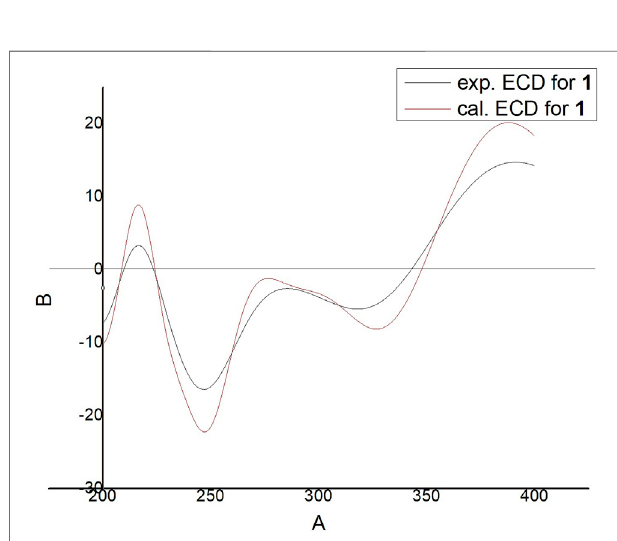
FIGURE 3 | Experimental and calculated ECD spectra of Compound 1